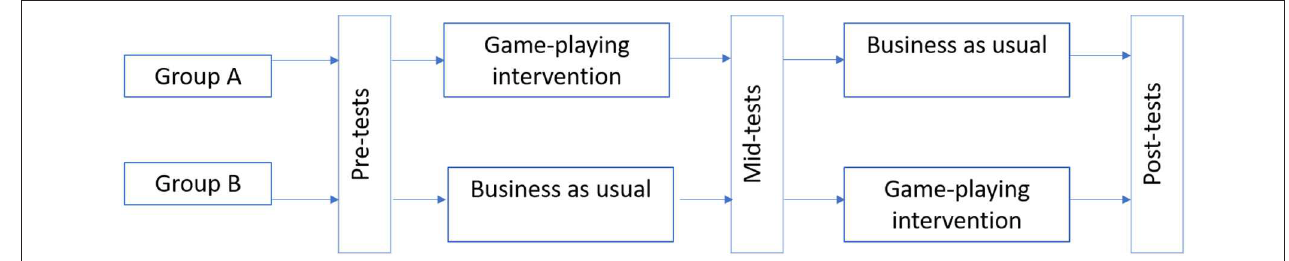
FIGURE 2 | Experimental